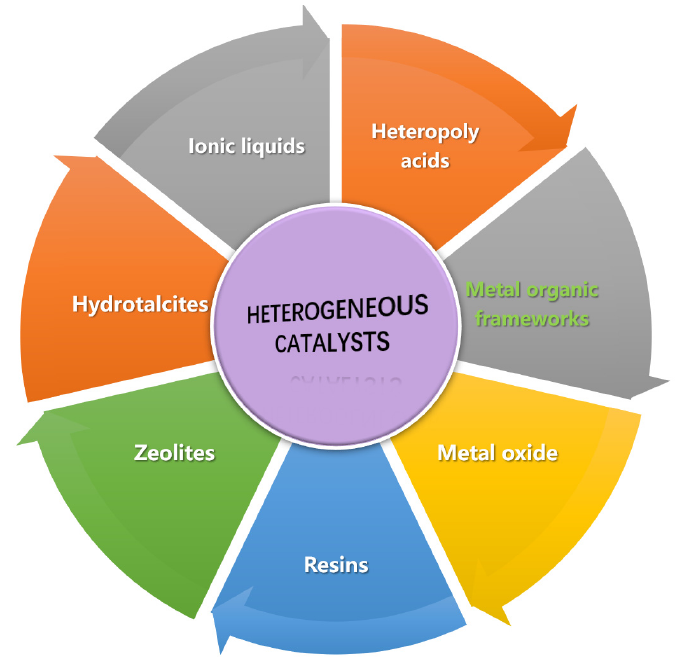
Figure 1. Various heterogeneous catalysts.